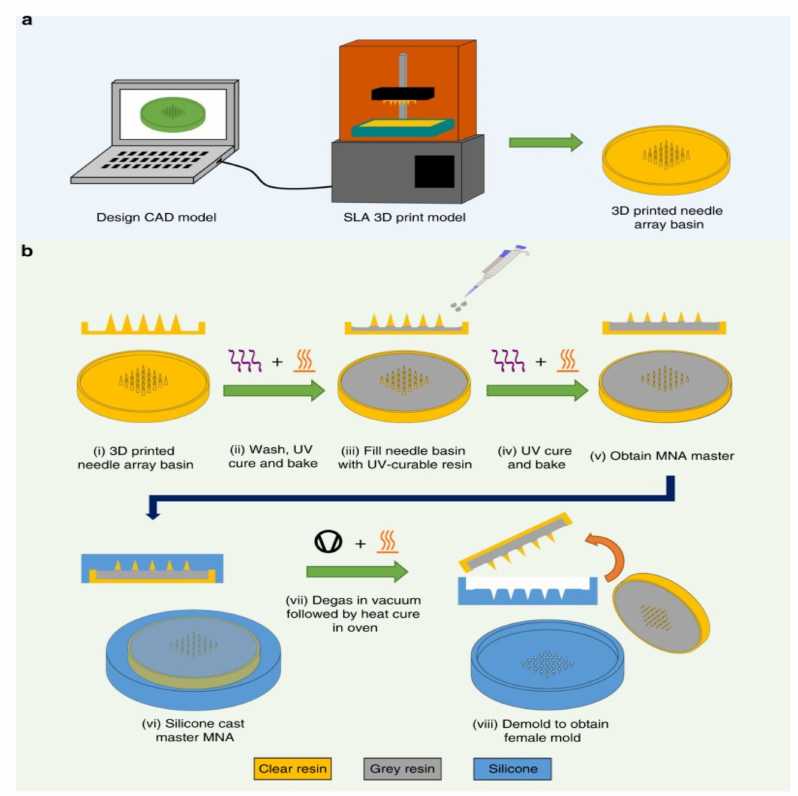
Figure 15. Overview of “Print and Fill” fabrication method: ( a ) Needle array basin design followed by 3D printing of the design using a Form 2 SLA printer. ( b ) MNA master mold fabrication method (i) take 3D printed needle array basin; (ii) washing followed by UV curing and baking of printed needle array basin; (iii) filing of needle array basin with UV-curable resin; (iv) second UV cur- ing and baking; (v) obtain MNA master; (vi) silicone casting of MNA master; (vii) silicone mold is degassed followed by heat cure in oven; (viii) demolding to obtain usable MN mold [63]. Reproduced with permission from Kevin J. Krieger et al., Simple and customizable method for fabrica- tion of high-aspect ratio MN molds using low-cost 3D printing; published by Springer Nature,